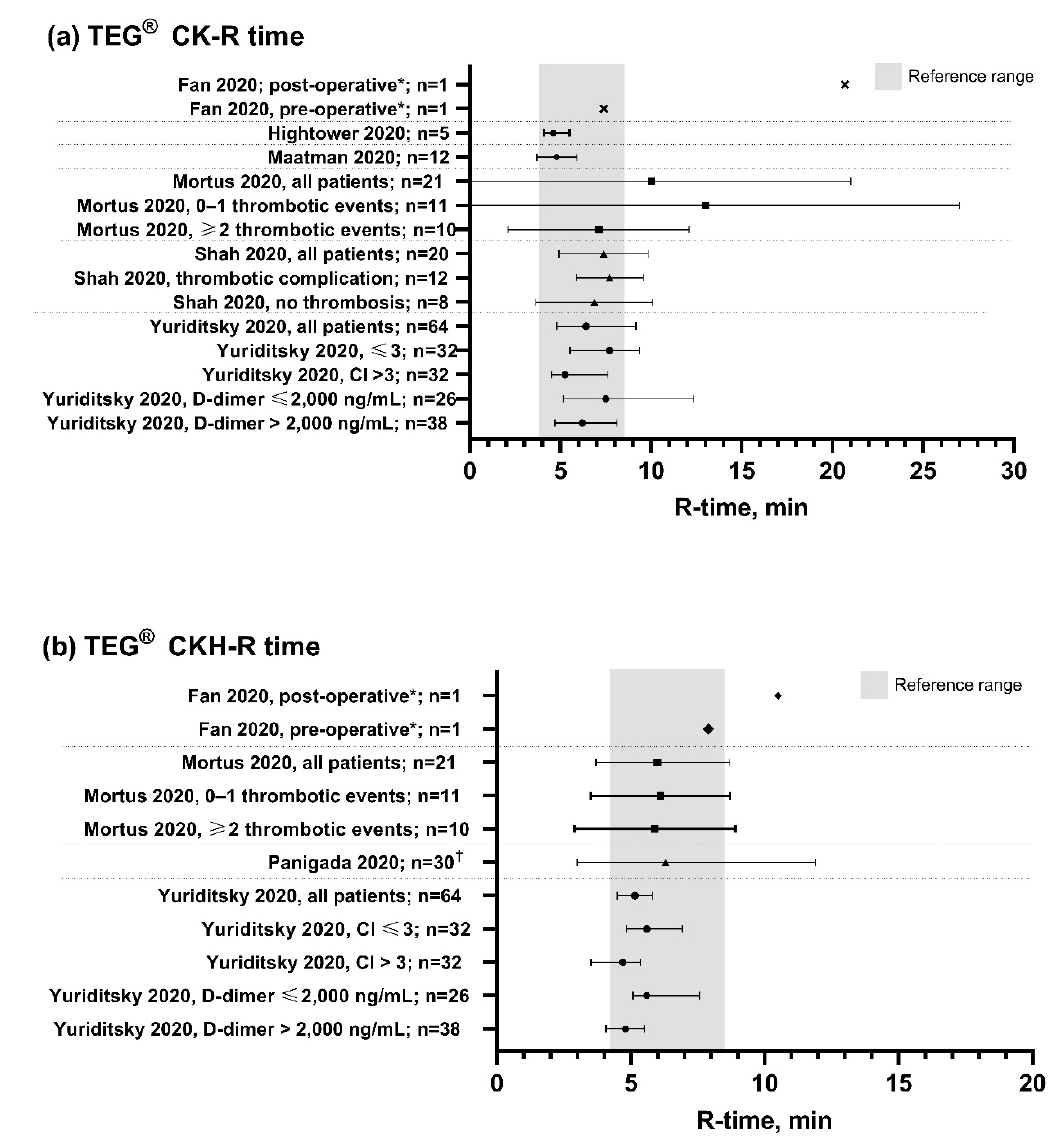
Figure 4. TEG® R-time values observed in patients with COVID-19. Grey bars show the normal TEG® reference range [27]. CK, citrated kaolin assay; CKH, CK with heparinase assay; R-time, reaction time. * TEG® measurements recorded before and after endovascular stent graft exclusion of the aortic thrombus and right lower limb embolectomy following diagnosis of acute ischemic limb. † Measurements were repeated on two consecutive days in six patients. Data points are mean with standard deviation error bars for normally distributed data, or median with interquartile range error bars for data that were not normally distributed. Dotted lines separate different studies with different patient populations. Data are not directly comparable between studies.